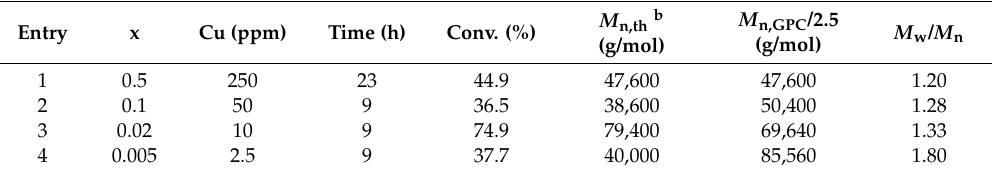
Table 1. Effect of initial Cu(II) concentration on the polymerization of acrylonitrile (AN) at ambient pressure a .